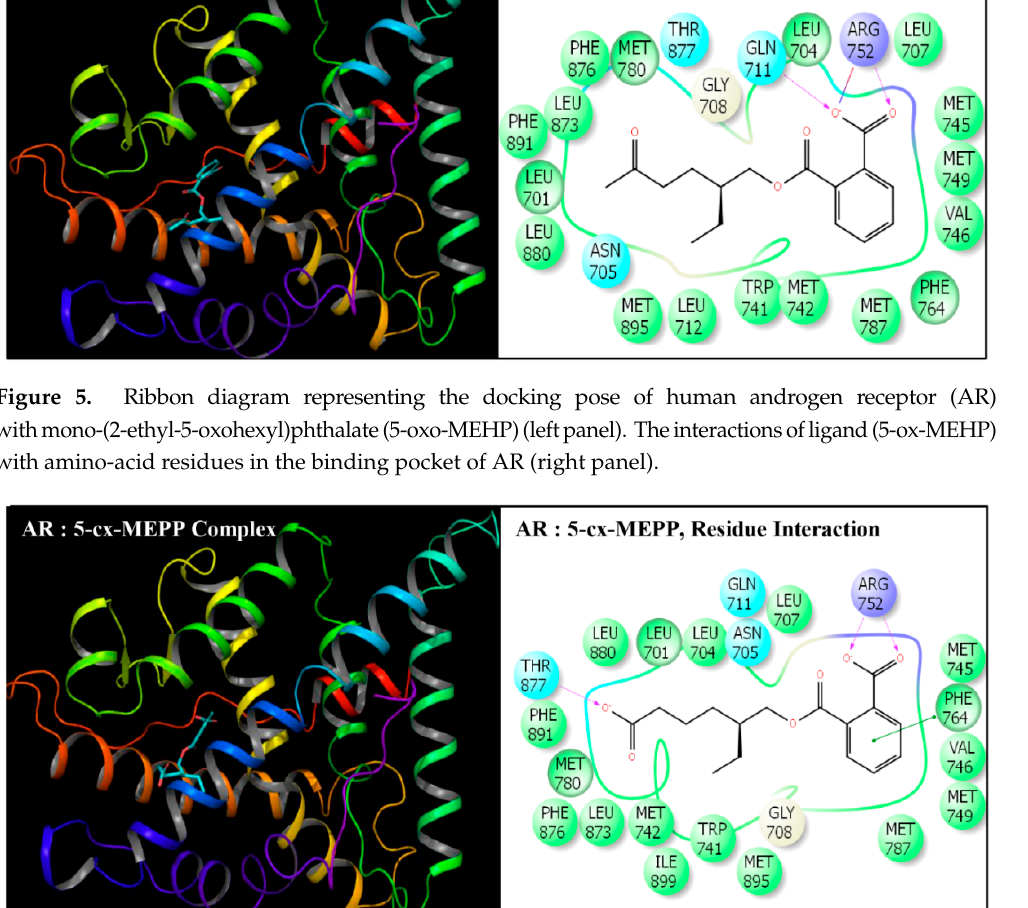
Figure 7. Ribbon diagram representing the docking pose of human androgen receptor (AR) with mono-[2-(carboxymethyl)hexyl]phthalate (2-cx-MMHP)(left panel). The interaction of ligand (2-cx- MMHP) with amino-acid residues in the binding pocket of AR (right panel). Figure 8. Ribbon diagram representing the docking pose of human androgen receptor (AR) with native ligand testosterone (TST) (left panel). The interactions of ligand (TST) with amino-acid residues in the binding pocket of AR (right panel).